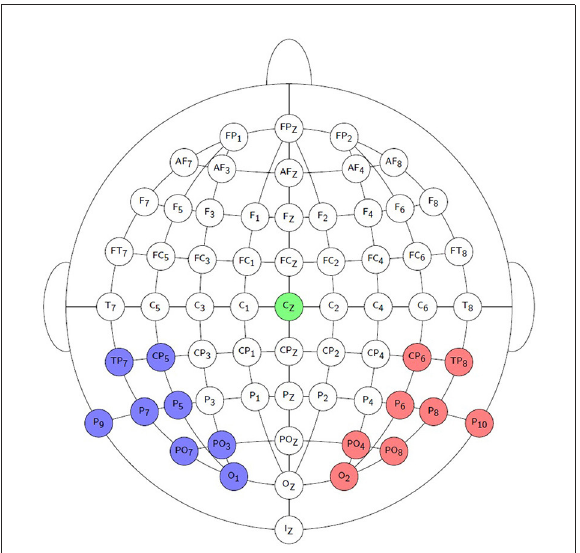
FIGURE2 Visualization of the EEG recording electrodes used to form the left channel (blue) and the right channel (red). The reference EEG electrode Cz is indicated by the green